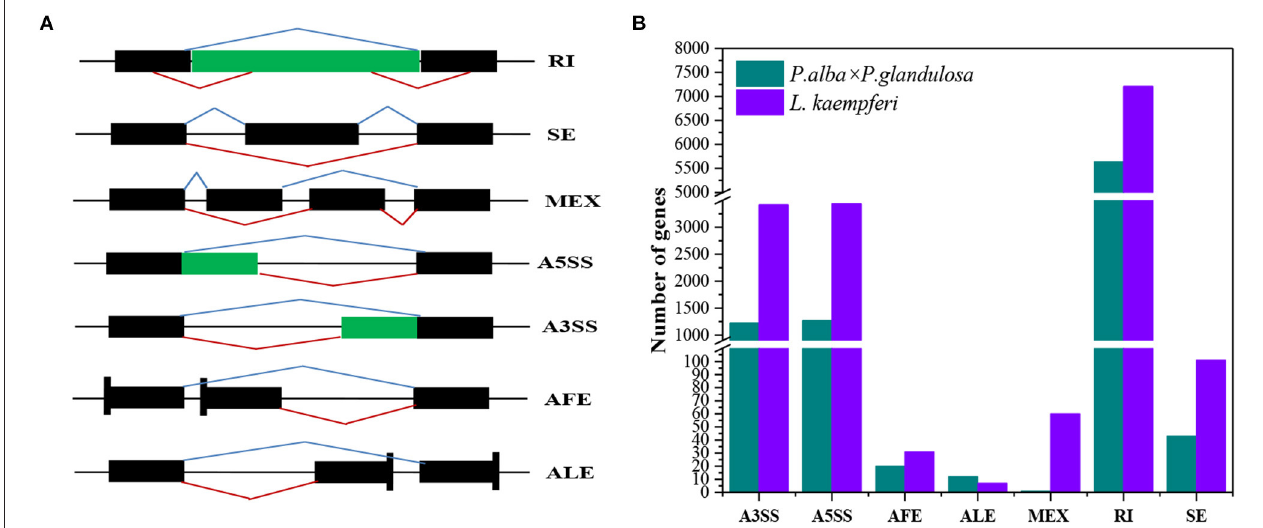
FIGURE 7 | Comparison of different alternative splicing events between the two tree species. (A) Splicing patterns of seven kinds of alternative splicing. (B) Distributions of seven kinds of alternative splicing in each of the two tree species. A3SS, alternative 3 ′ splice site; A5SS, alternative 5 ′ splice site; AFE, alternative first exon; ALE, alternative last exon; MEX, mutually exclusive exon; RI, retained intron; SE, skipped exon. Black blocks are exons, while the green blocks and black lines represent introns. Blue broken lines above the block(s) represent normal transcripts; red broken lines are the alternative splicing events.